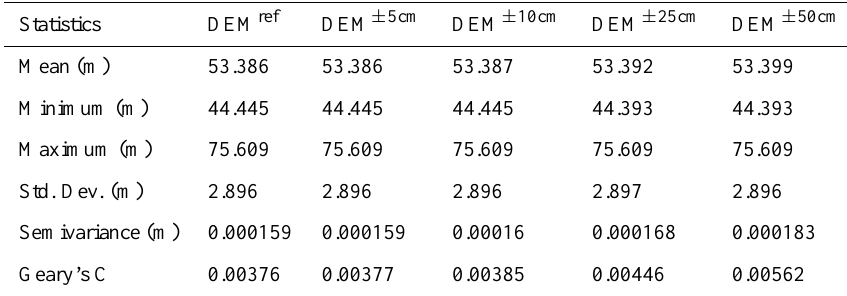
Table 4. Descriptive statistics for each scaled